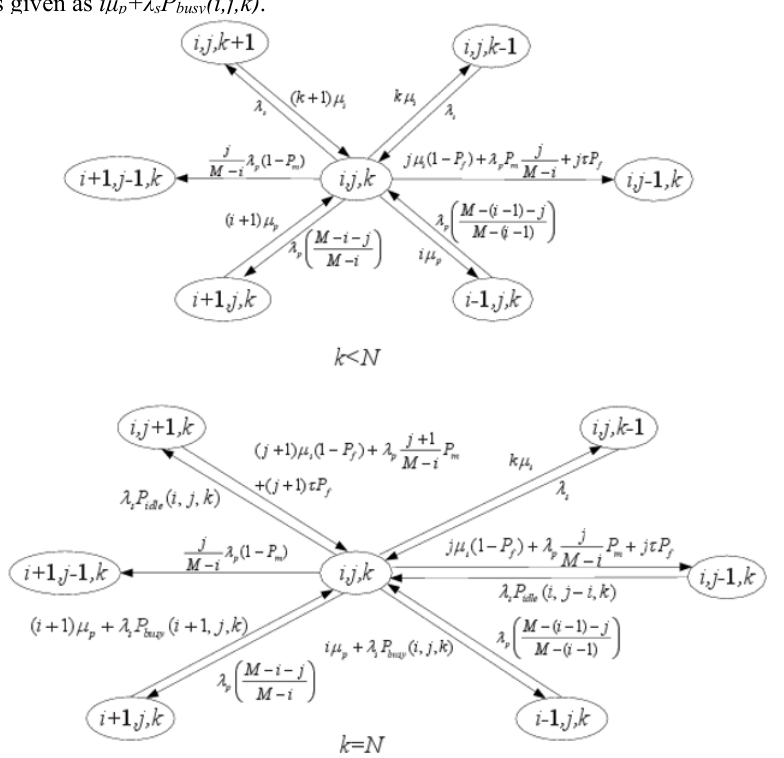
Fig. 2. Rate diagram of state (i,j,k) in the OSA scheme with non-hopping under imperfect